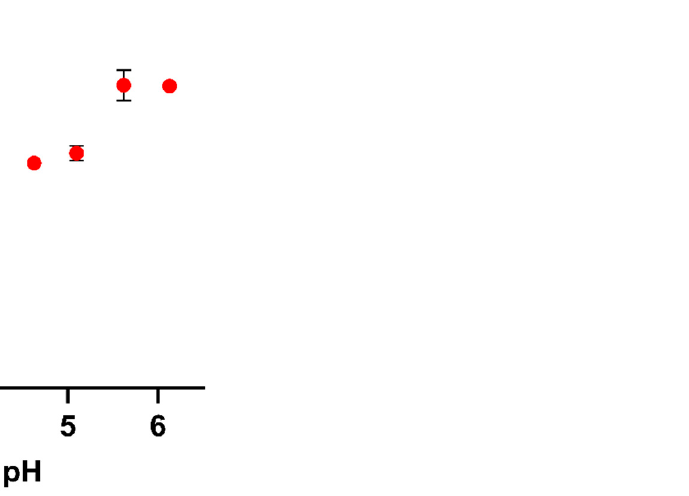
Figure 4. The effect of pH on time taken for 2% ( w / v ) solutions of apple pectin of pH 3.14, 3.67, 4.08, 4.63, 5.1, 5.62, and 6.13 containing 5 mM CaCl 2 to flow between two graduations of a 1 mL glass pipette. Error bars indicate S.D. ( n = 3).